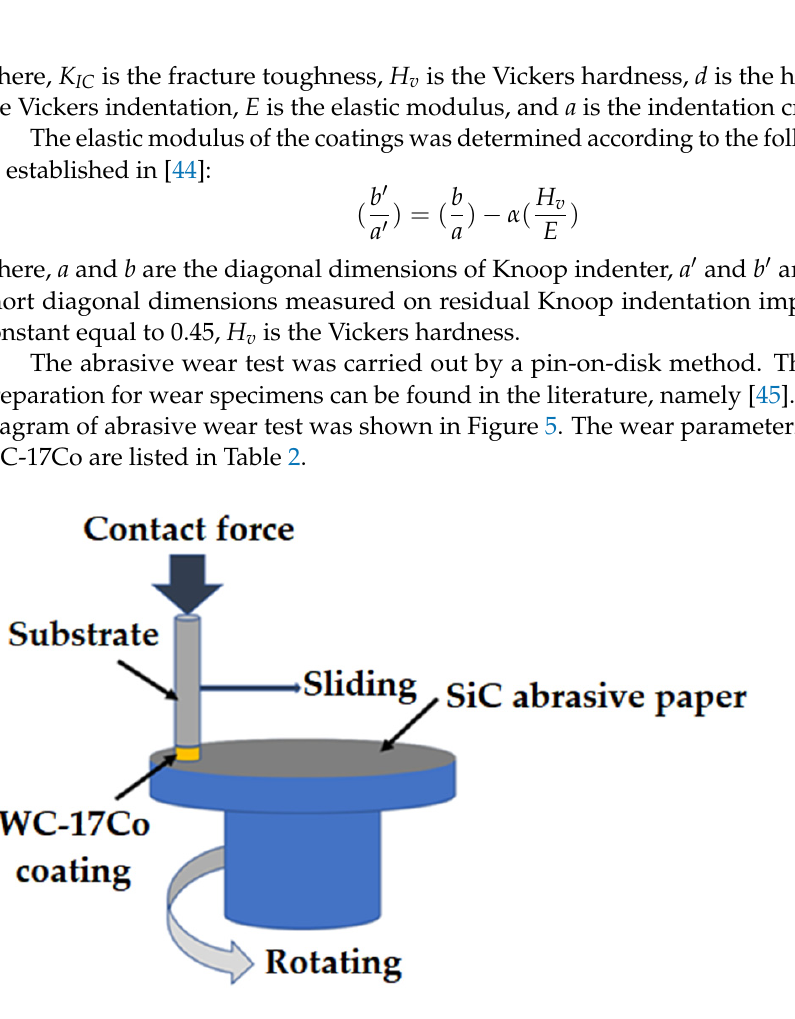
Table 2. The wear parameters of as-sprayedWC-17Co coatings .